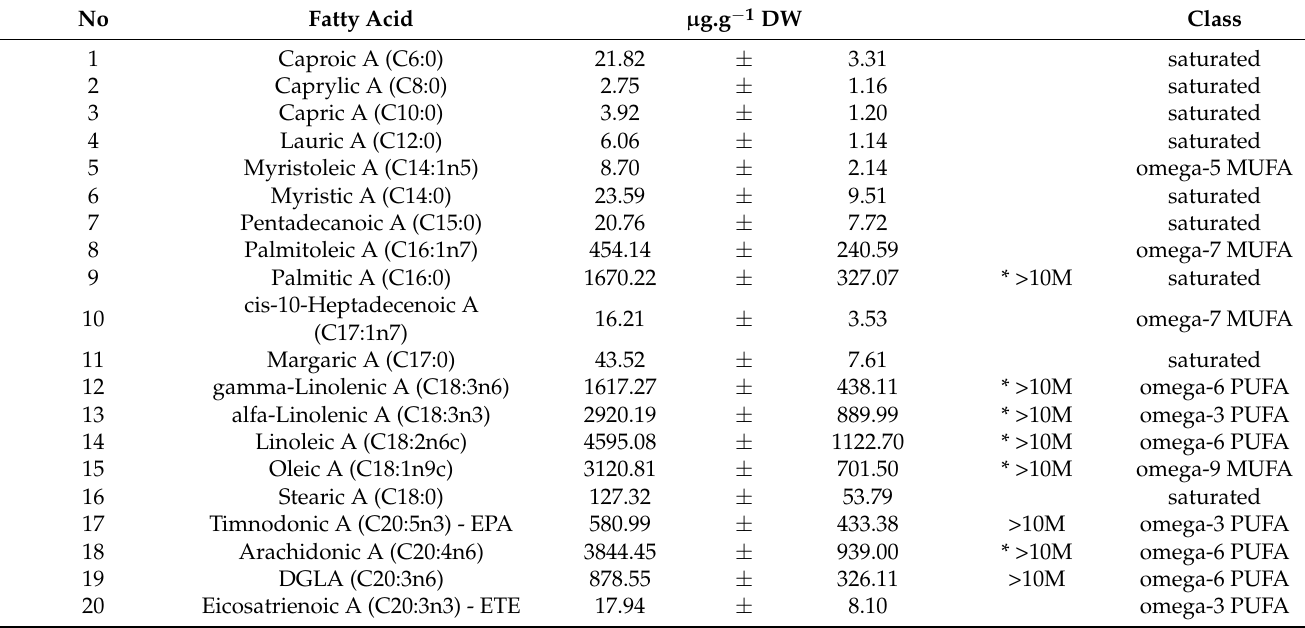
Table 3. The average content of individual FAMEs in all tested fern fiddlehead